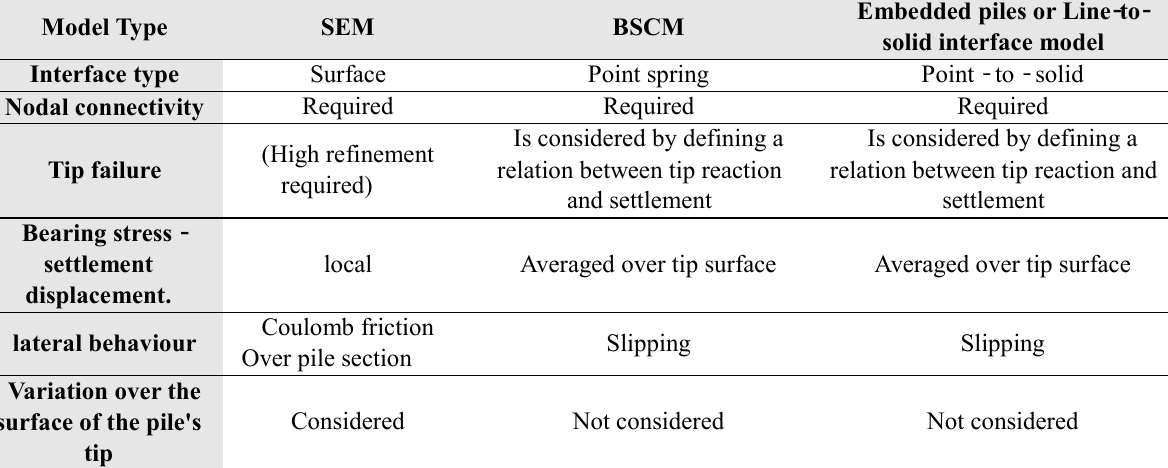
Comparison between three kinds of models for pile tip bearing